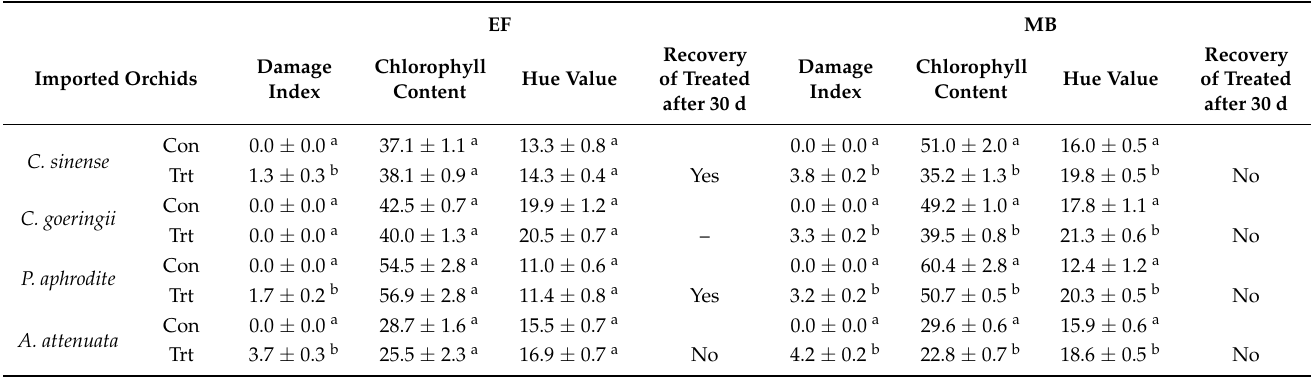
Table 3. Effect of ethyl formate (EF) and methyl bromide (MB) fumigation on the overall damage, chlorophyll contents and hue values of orchids right after scale-up fumigation trials (30 and 150 m 3 ). Different letters (a, b) on means indicate significant differences between treated and untreated controls at p < 0.05. n = 6. – no need to